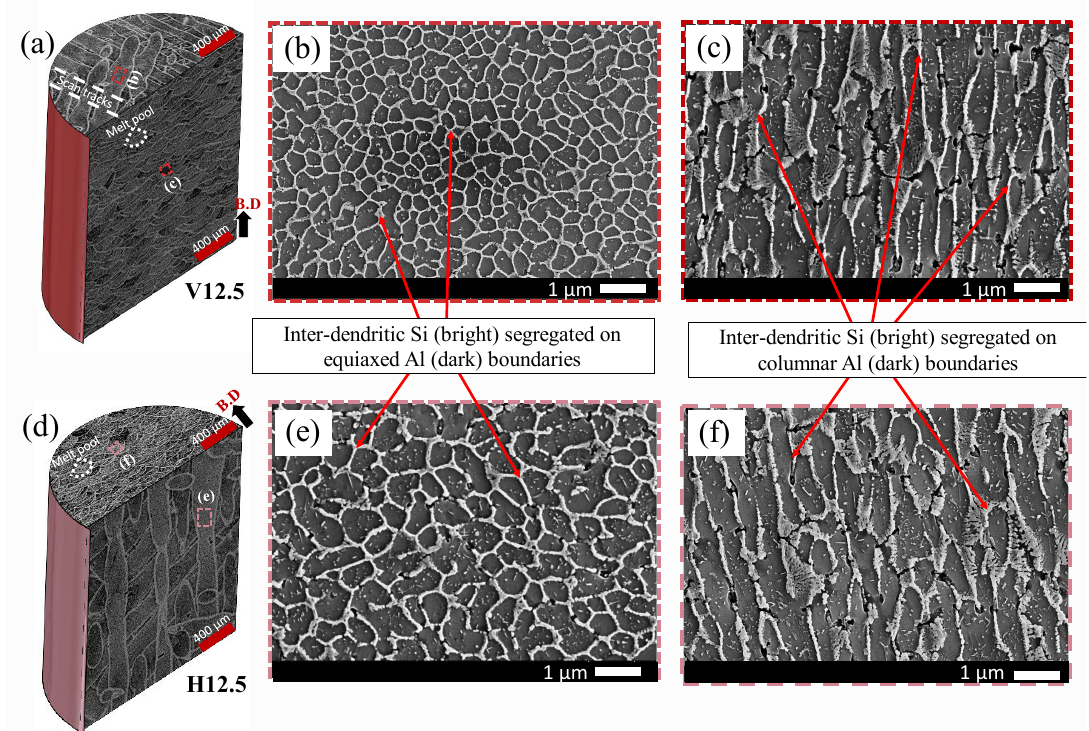
Figure 4. ( a , d ) Melt pool characteristics in the planes perpendicular and parallel to the build directions in samples V12.5 and H12.5, respectively. ( b,c,e,f ) High magnification SEM images showing the cells’ structure in the directions perpendicular and parallel to the build direction for ( b , c ) V12.5 and ( e , f ) H12.5 samples. (B.D = build direction).